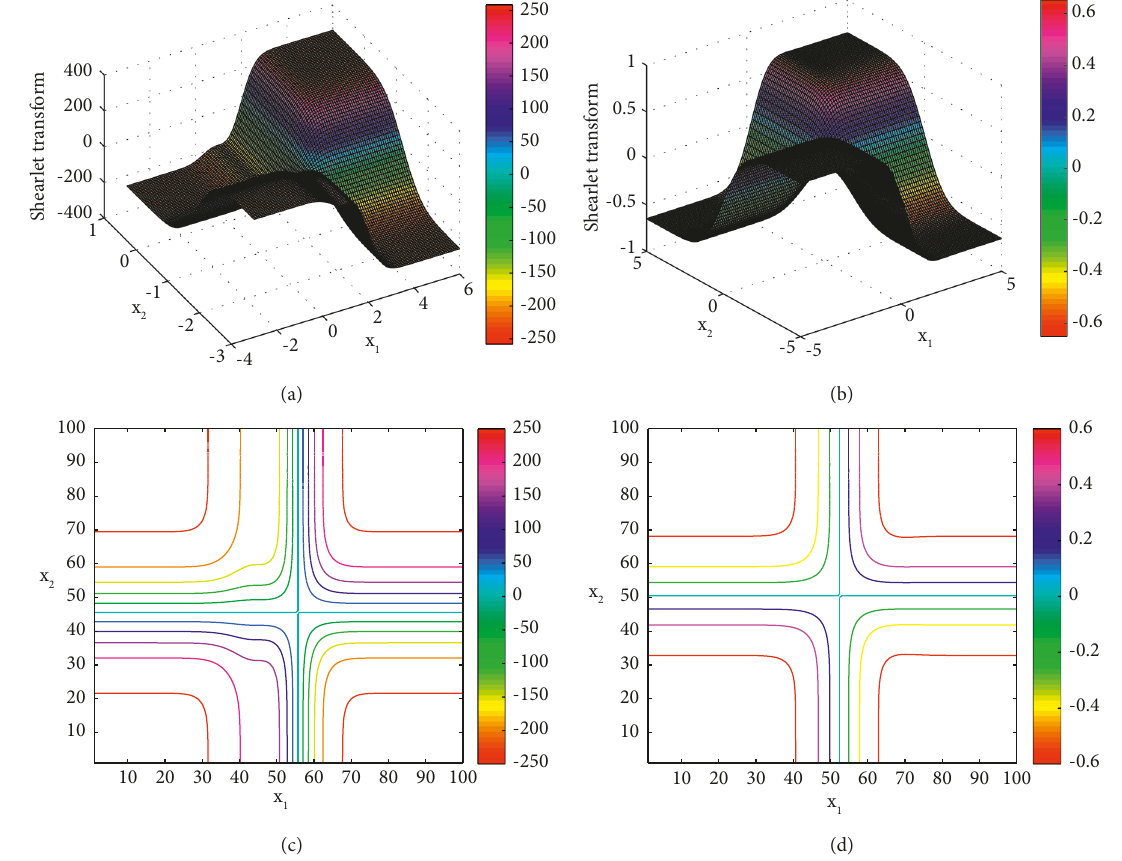
,x ) � exp − ( x 2 + x 2 ) /2 􏼈 􏼉 with respect to analyzing function 1 2 1 2